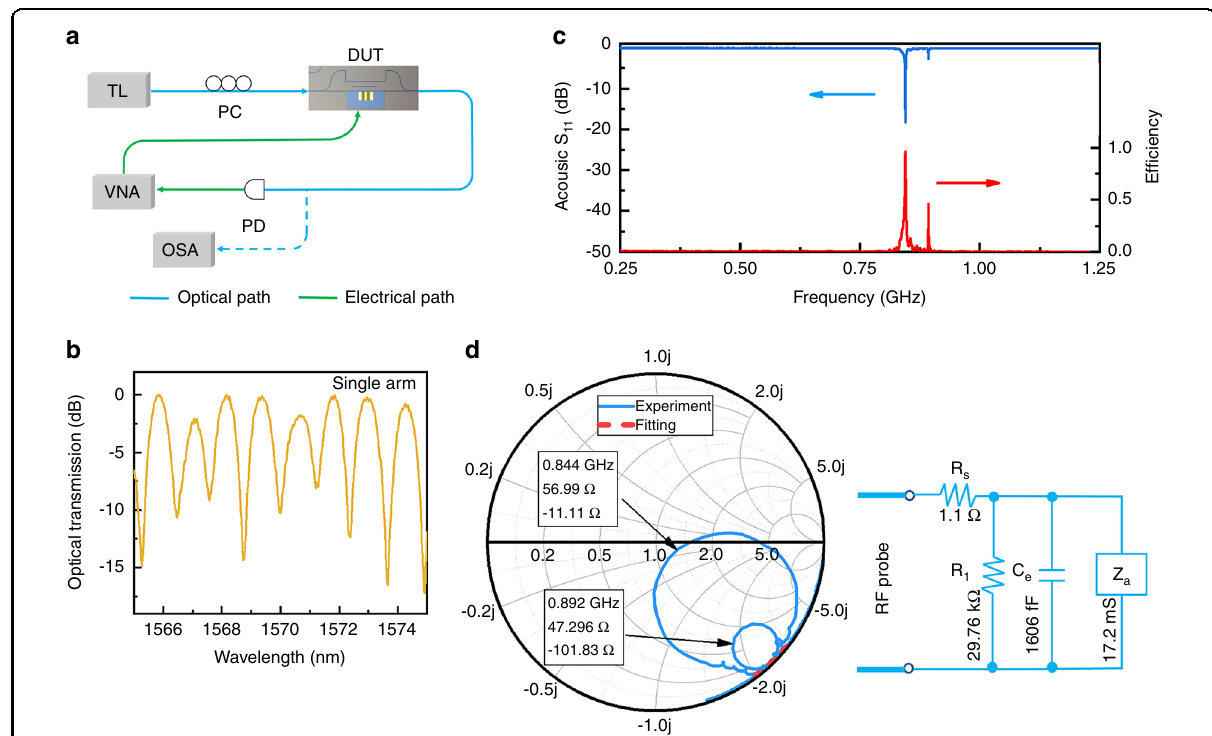
Fig. 3 Characterization of microwave-to-acoustic conversion in the single arm-modulated AO modulator. a Schematic diagram of the device measurement system. b Optical transmission spectrum of an MZI-based AO modulator with the single arm modulation con fi guration. c S 11 re fl ection spectrum and conversion ef fi ciency of the fabricated IDT. d Smith chart of the fabricated IDT and the corresponding effective circuit model. TL: tunable laser, VNA: vector network analyzer, DUT: device under test, PC: polarization controller, PD: photodiode, OSA: optical spectrum